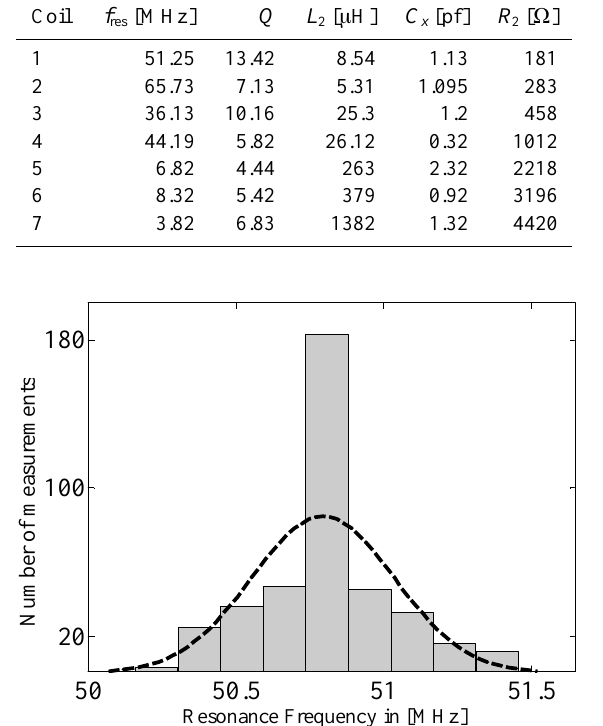
Figure 15. Error distributions in wirelessly measured resonance frequency of a single micro coil with 33 turns measured at the center of loop antenna with mean resonance frequency of 50.82MHz. The dotted line represents the Gaussian distribution of the corresponding